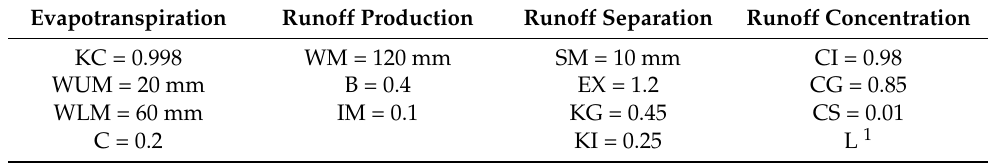
Figure 4. Comparisons between simulated and observed flows of flood events: ( a ) calibration at the Huangnizhuang station; ( b ) validation at the Huangnizhuang station; and ( c ) validation in the entire Meishan basin. The box-plots present the distributions of four statistics (peak flow error, PK RE ; flood volume error, FV RE ; peak flow occurrence time error, OT RE ; and Nash–Sutcliffe coefficient, NS) for all considered flood events. The numbers on the top axes —with the two-digit format for flood ID and three-digit for ending time step—separate the artificially attached series of flood events. Table 1. Calibrated parameter values of the Xinanjiang model for flood events shown in Figure 4a.